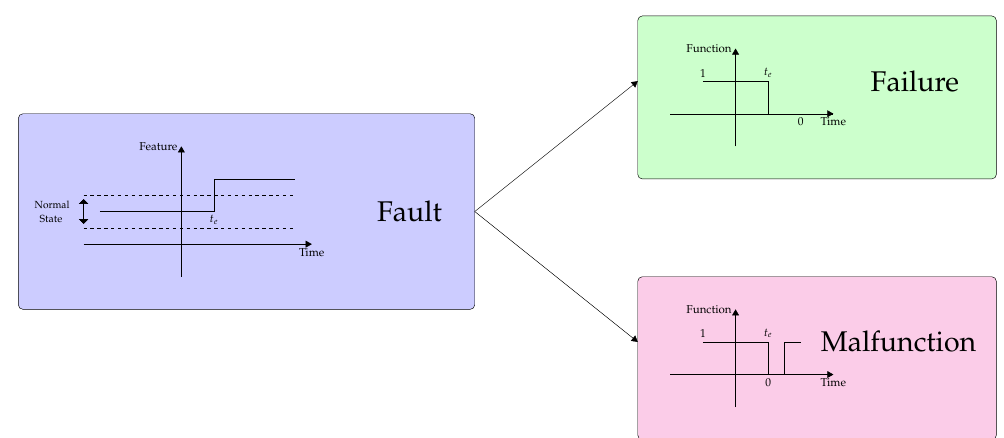
Figure A1. Scheme of the relation between faults, failures and malfunctions